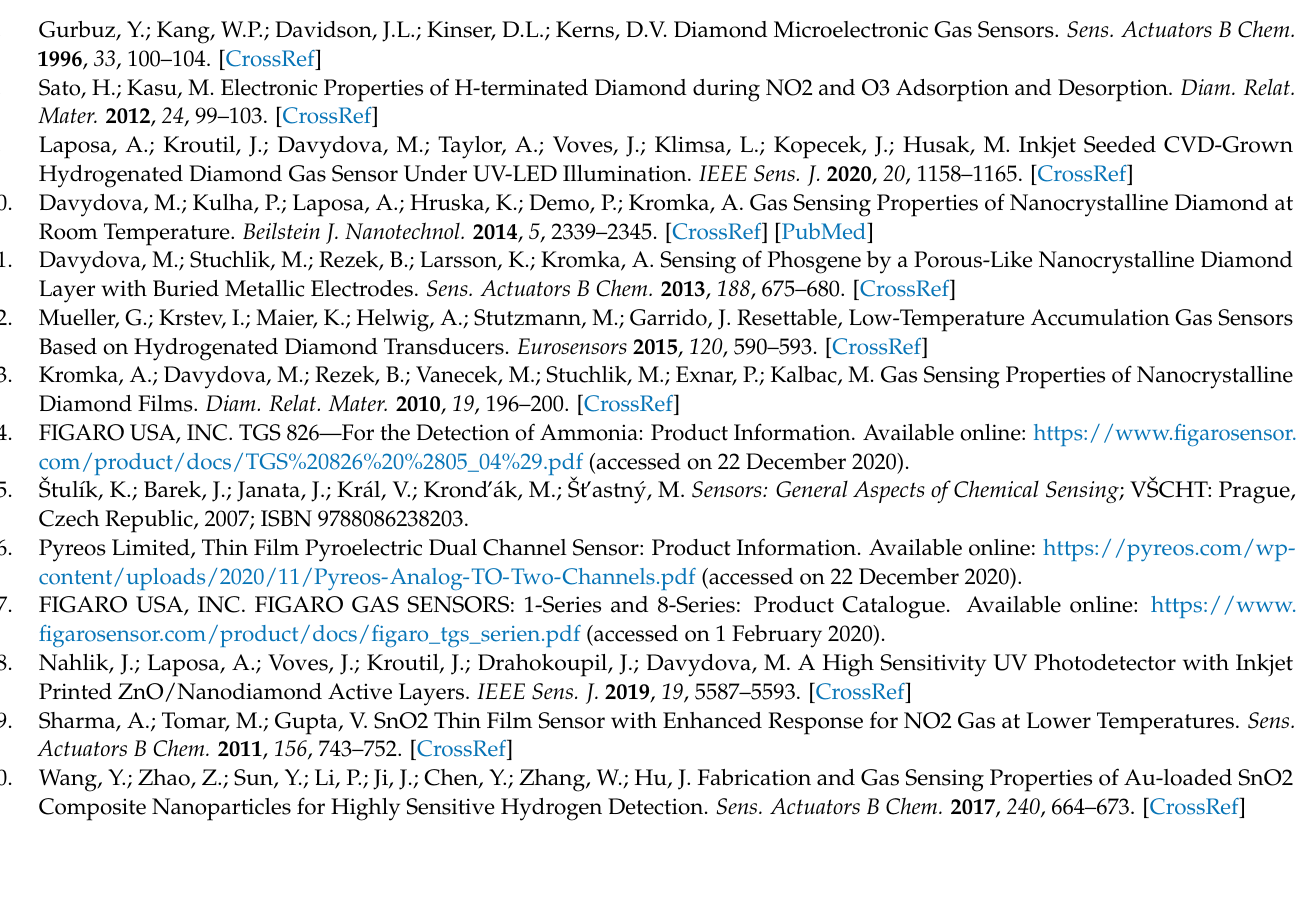
FIGARO USA, INC. FIGARO GAS SENSORS: 1-Series and 8-Series: Product Catalogue. Available online: https://www. figarosensor.com/product/docs/figaro_tgs_serien.pdf (accessed on 1 February